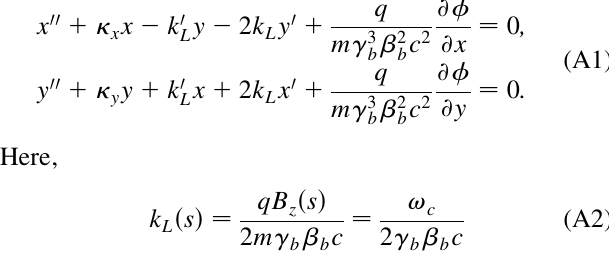
and ~ rr aligned along ~ xx and ~ yy coordinate ~ xx ~ yy